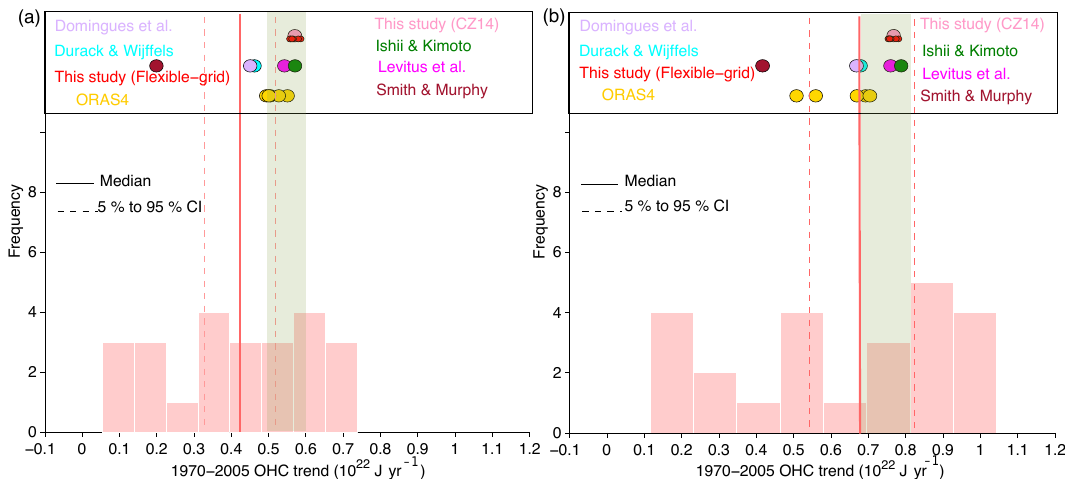
Figure 3. OHC trends during the 1970–2005 period in observations and CMIP5 models. (a) 0–700m. (b) Full depth. For models, the histograms are the distribution of CMIP5 results, and the median of the CMIP5 multimodel results is shown in solid line, with the 5–95% confidence interval in dashed lines. For observations, we present the linear trends by different studies: this study (both CZ14 and the flexible- grid method), five estimates in Durack et al. (2014) after adjustment, and five ensembles of ORAS4 reanalysis. The 5–95% confidence intervals for observations are shaded in light green. A quadratic fit to the entire pre-industrial control run was used to correct the CMIP5 time series for model